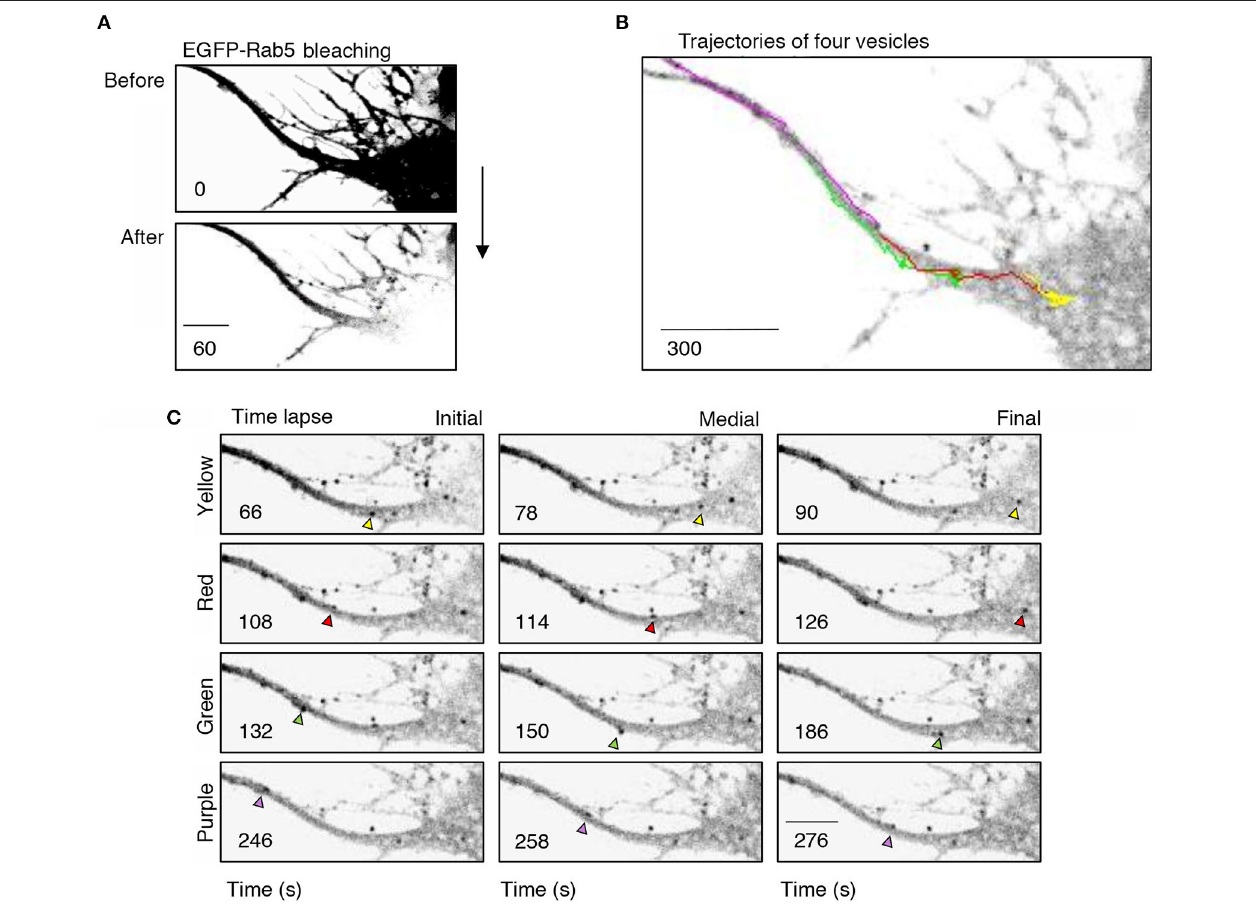
FIGURE 4 | Retrograde transport of EGFP-Rab5 endosomes from dendrites to the cell body. (A) Cell body and primary dendrite of a hippocampal neuron before (upper panel) and after photobleaching (lower panel). (B) Representative image of a time-lapse recording of EGFP-Rab5-associated fluorescence after photobleaching indicating the trajectories of four vesicles positive for EGFP-Rab5 performed in a primary dendrite and soma of a hippocampal neuron stimulated with BDNF. (C) Representative image of the initial, medial and final point of the trajectories shown in (B) . The vesicles whose trajectories were labeled in (B) are indicated with arrowheads of the same color of the trajectory. The numbers inside the panels indicate the seconds after photobleaching. Scale bar, 10 µ